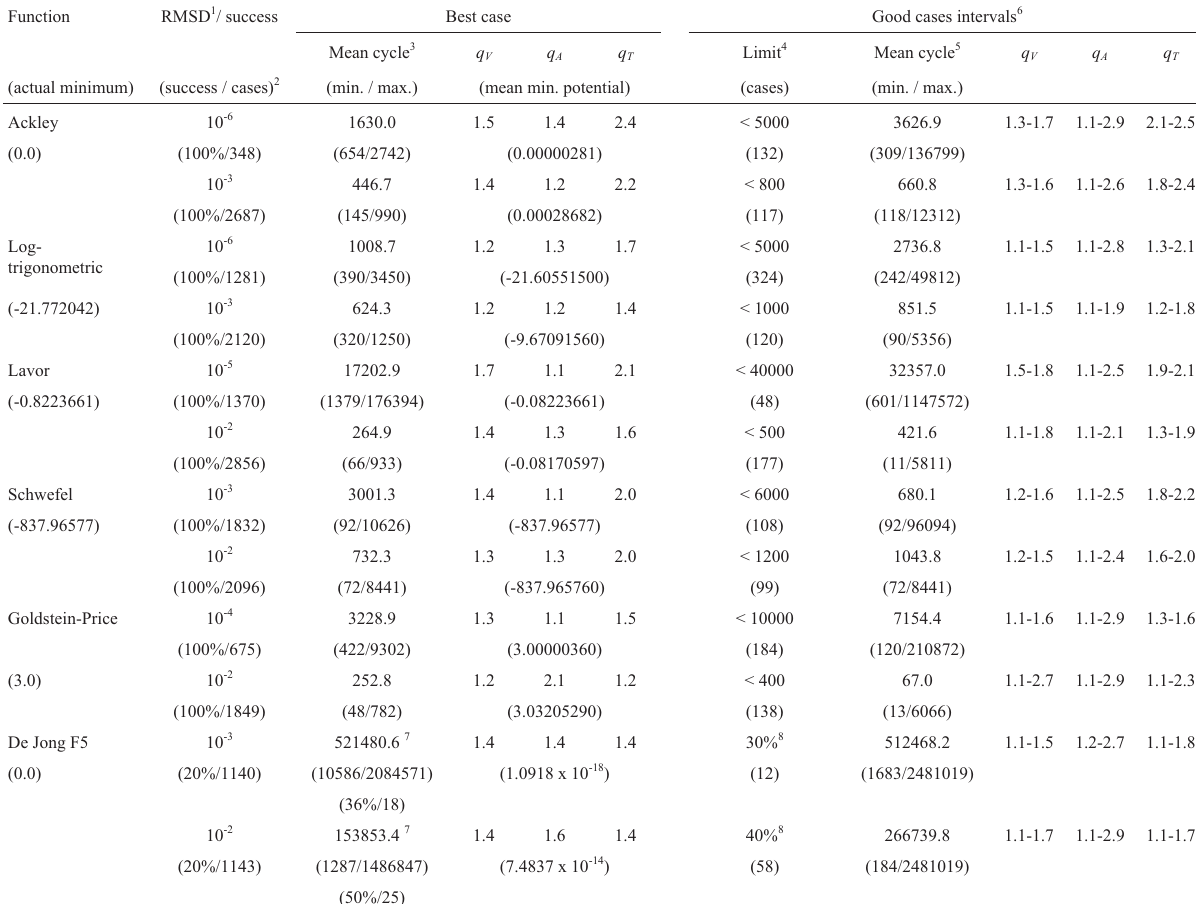
Table 1 - Performance data of the SGSA algorithm for the selected two-dimension functions. Function RMSD 1 /